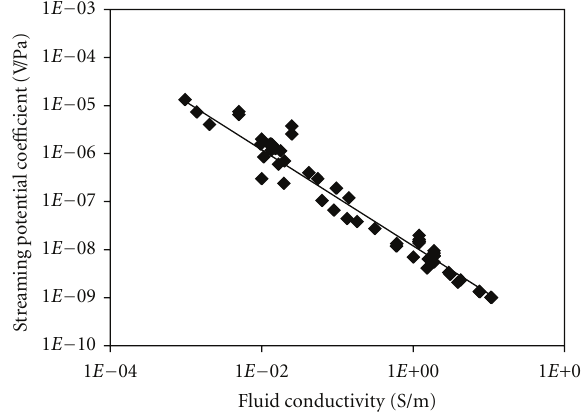
Figure 4: Streaming potential coe ffi cient from data collected (in absolute value) on sands and sandstones at pH 7-8 (when available) from Ahmad [100]; Li et al. [67]; Jouniaux and Pozzi [101]; Lorne et al. [86]; Pengra et al. [102]; Guichet et al. [21]; Perrier and Froidefond [103]; Guichet et al. [88]; Ishido and Mizutani [96]; Jaafar et al. [98]. The regression (black line) leads to C s 0 = − 1 . 2 × 10 − 8 σ − 1 f . A zeta potential of − 17 mV can be inferred from these collected data from All`egre